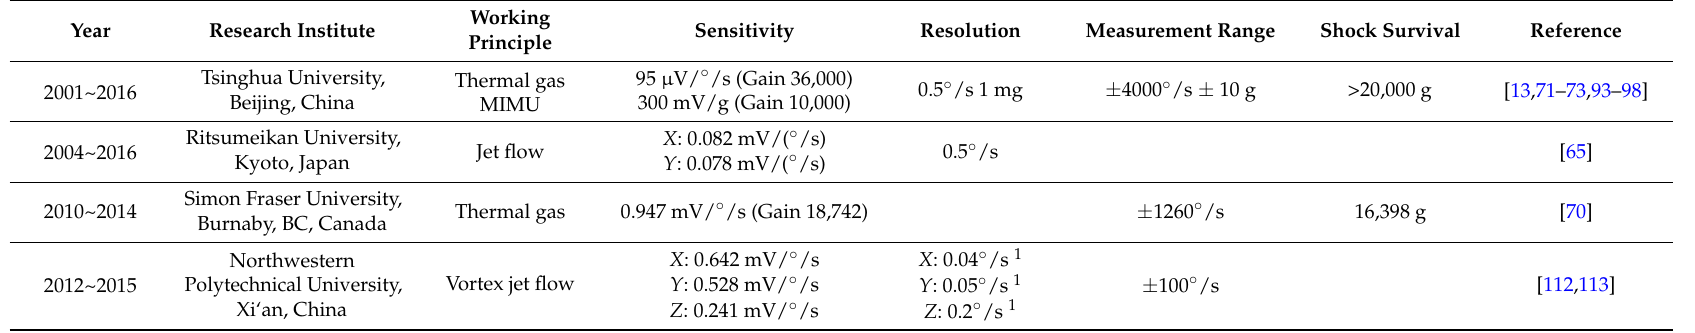
Table 2. Typical research results of micromachined fluid